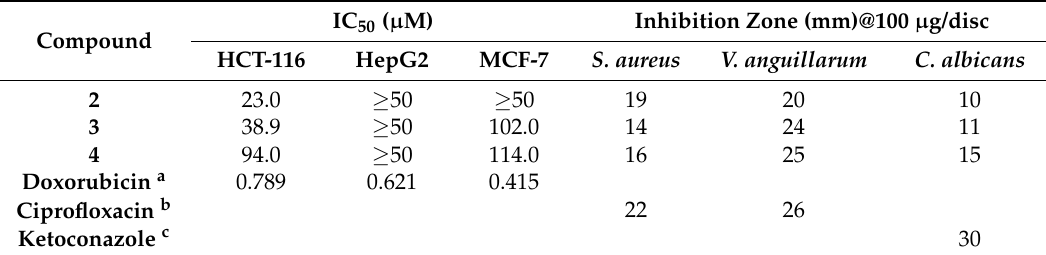
Table 3. Cytotoxic and antimicrobial activities of compounds 2 – 4 .